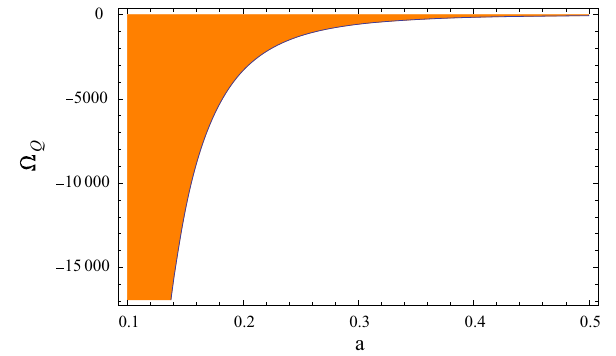
Fig. 3 The shaded portion is the admissible domain for (cid:6) Q in the negative region for ω d = 0 . 45, (cid:6) m